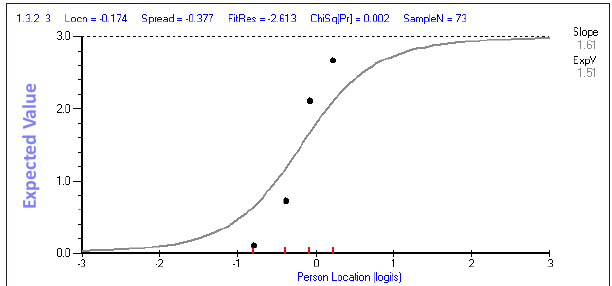
FIGURE 4: Item characteristic curve for Item 1.3.2, indicating